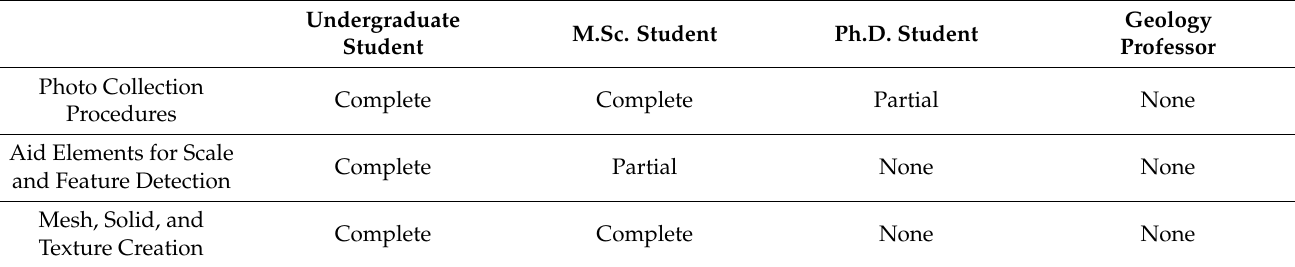
Table 2. Methodological contents received by the